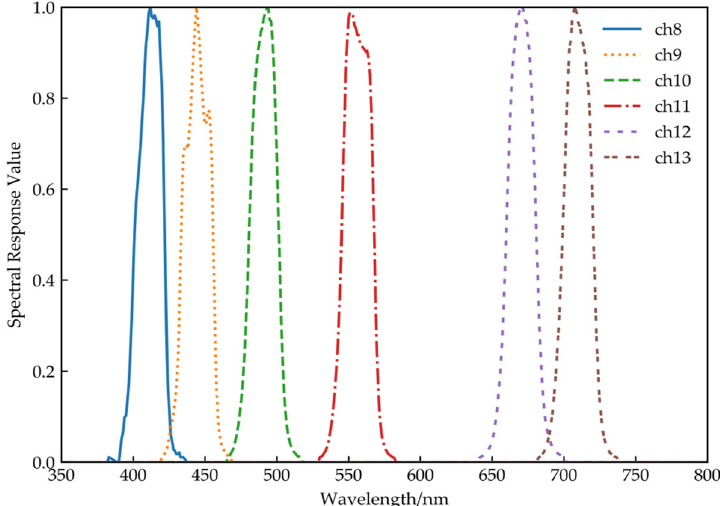
Figure 1. Spectral response function of the FY-3D/MERSI-II.